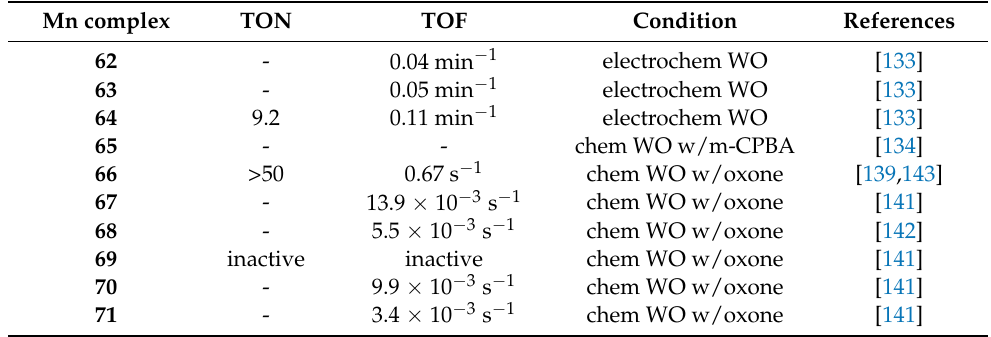
Table 5. Selected catalytic parameters and experimental conditions for Mn catalysts 62–71 for water oxidation. Electrochemical and chemical water oxidation are abbreviated as ‘electrochem WO’ and ‘chem WO’, respectively. The TON or TOF values that are not listed in this table are unavailable in